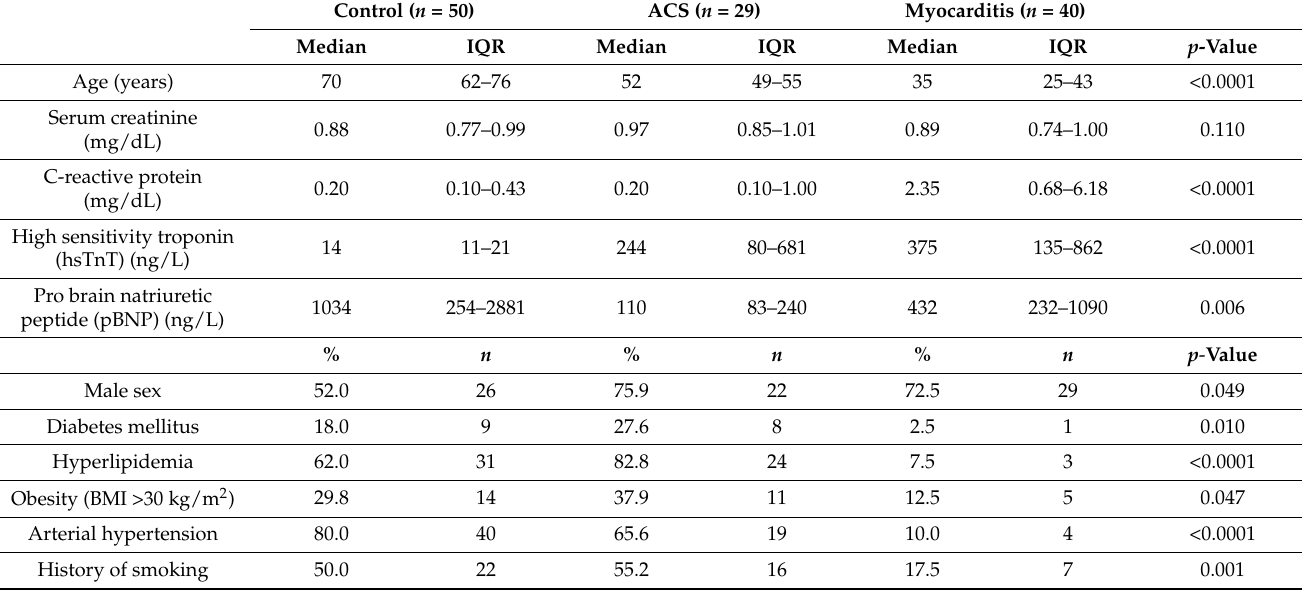
Table 1. Baseline characteristics, laboratory parameters and comorbidities of enrolled